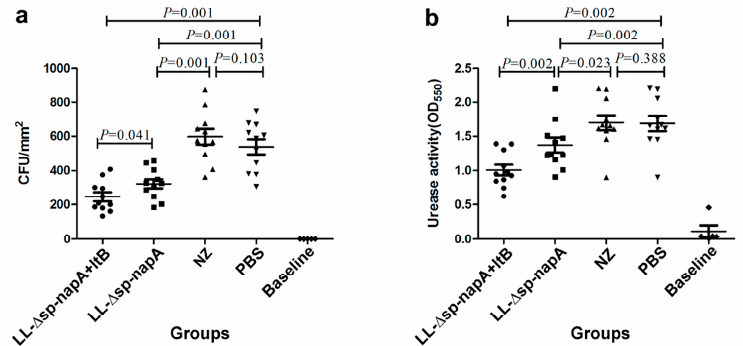
Figure 5. Assessment of H. pylori colonization and histological change in the stomachs. The gastric tissues of mice were examined in the first week after H. pylori challenges. ( a ) Gastric H. pylori colonization levels assayed via bacterial cultivation. ( b ) Gastric bacterial burden evaluated using the urease tests. ( c ) Comparison of the groups on severity of gastric inflammatory changes. Data were expressed as mean ± SEM. Error bars indicate standard deviations. NZ- Δ sp-napA , NZ- Δ sp-napA+ltB , NZ and PBS groups ( n = 11 each) were gavages with NZ3900/pNZ - Δ sp -napA , mixture of NZ3900/pNZ- Δ sp- napA and NZ3900/pNZ-sp- ltB , NZ3900/pNZ8110 and PBS, respectively, and challenged with H. pylori . No gavages were performed on Baseline group ( n = 10). Ns: no significance; * : p < 0.05, Fisher's LSD test, compared with the PBS or designated group.